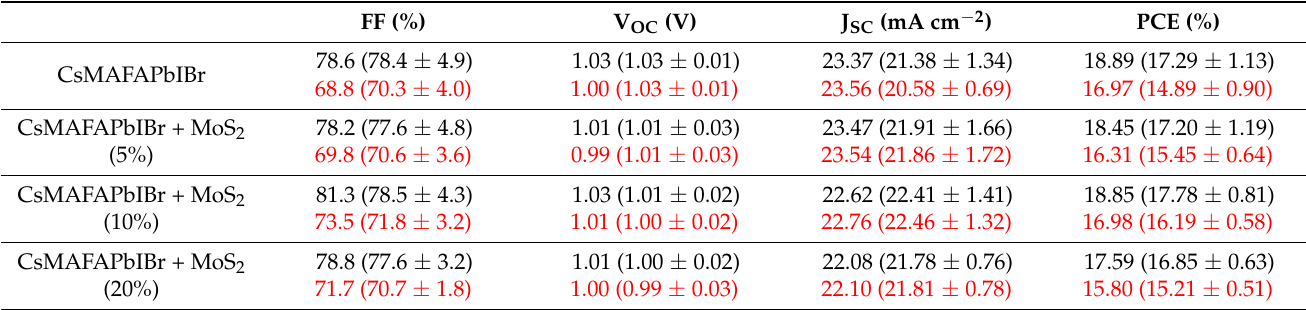
Figure 9. J-V curves of the CsMAFAPbIBr best-performing PSC: ( a ) CsMAFAPbIBr; ( b ) CsMAFAPbIBr + MoS 2 (5%); ( c ) CsMAFAPbIBr + MoS 2 (10%); ( d ) CsMAFAPbIBr + MoS 2 (20%). Table 5. Photovoltaic characteristics of the CsMAFAPbIBr best-performing PSC and average values as well as standard deviations: reverse scan (black), forward scan